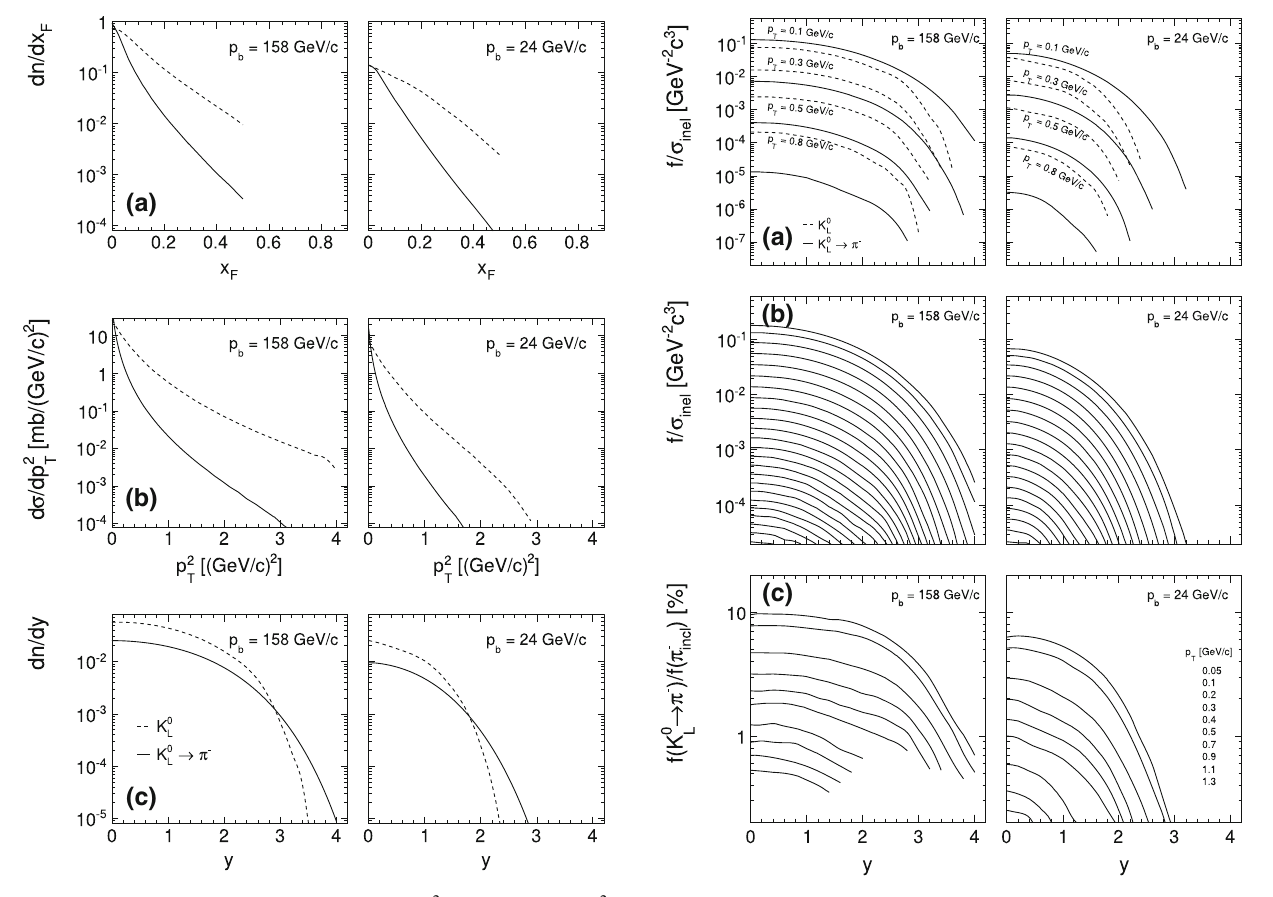
as a function of p 2 Fig. 19 a Invariant π − cross section f /σ inel as a function of y for T T four values of p T at 158 and 24 GeV/c beam momentum. Full lines for decay π − and broken lines for the parent K 0 . Subsequent p T values are L multiplied by 1/3 for clarity. b Invariant π − cross section f /σ inel from S K 0 decay as a function of rapidity for p T between 0.05 and 1.3 GeV/c L given for the sum of the three decay channels c percentage ratio of the total π − fromK 0 decaytotheinclusive,feed-downsubtracted π − L